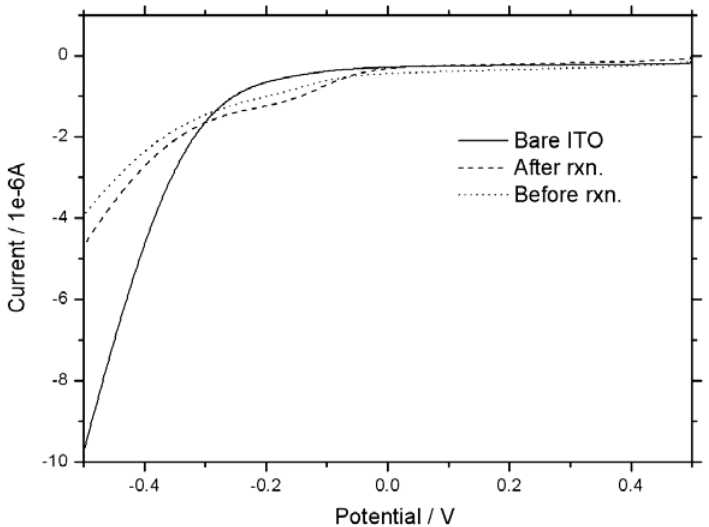
Figure 2. Cyclic voltammograms (CVs) of CuO hollow nanospheres on acetylene black, before (Dot line) and after the two cycle. (Dash